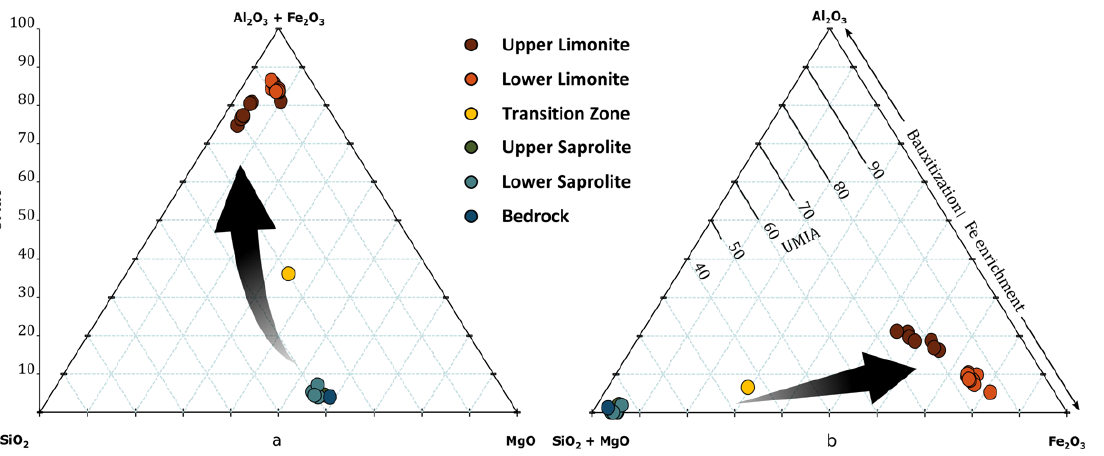
Figure 9. Chemical evolution of the laterite profile during weathering as shown by ( a ) molar ternary Al 2 O 3 +Fe 2 O 3 -SiO 2 -MgO (AF-S-M) and ( b ) molar ternary Al 2 O 3 -SiO 2 +MgO-Fe 2 O 3 (A-SM-F) diagrams. Both diagrams show weathering of an initially Mg- and Si-rich peridotite bedrock towards an Al- and Fe-rich limonite while ( b ) highlights that Fe-enrichment is predominant over bauxitization in the Sta. Cruz nickel laterite. Further shown is the ultramafic index of alteration (UMIA)